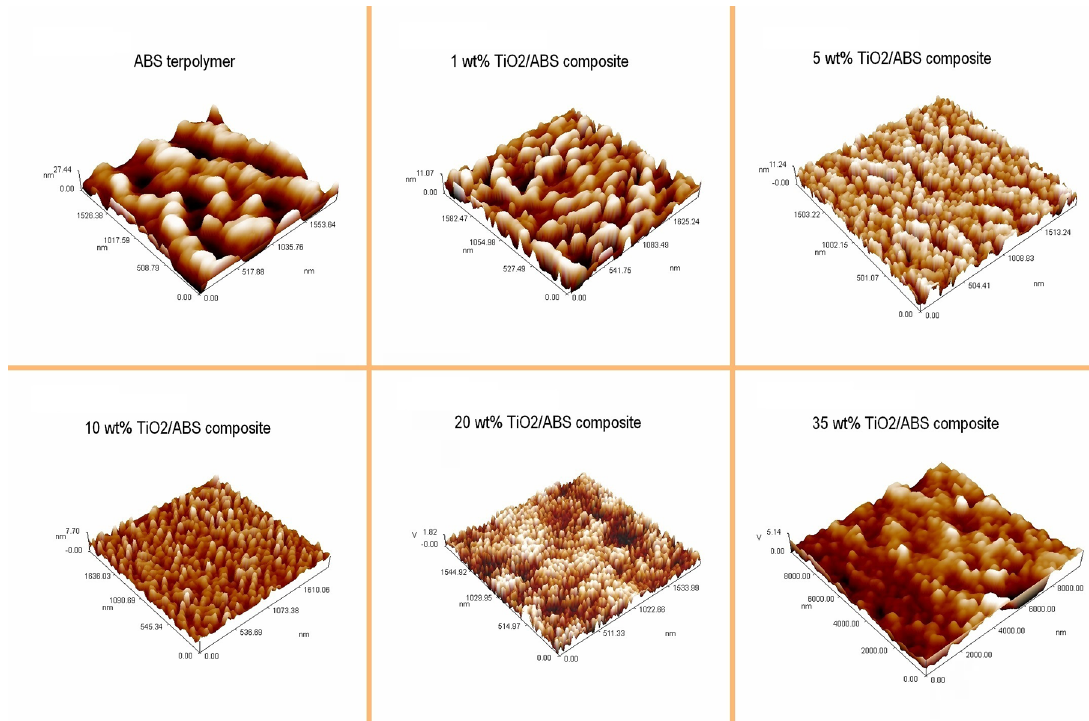
/ABS composites 2